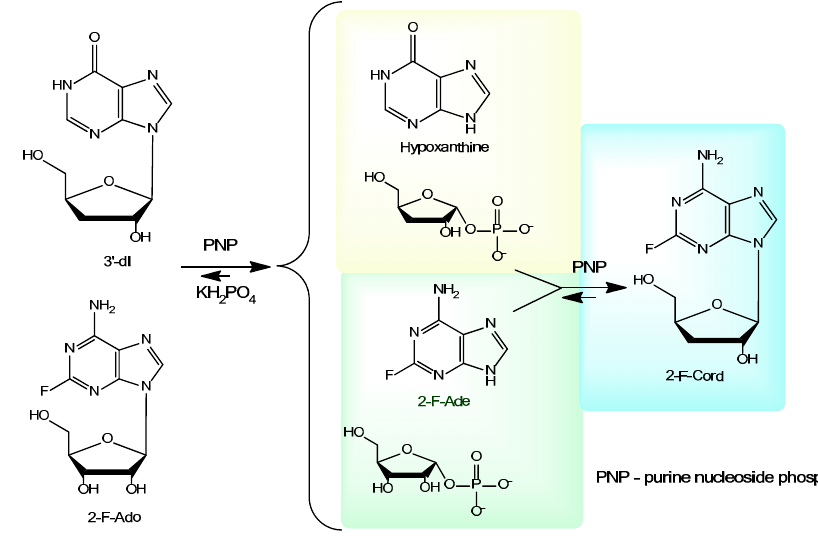
tremely low solubility of 2-fluoroadenine in water (less than 0.5 mM at 50° C) [18].